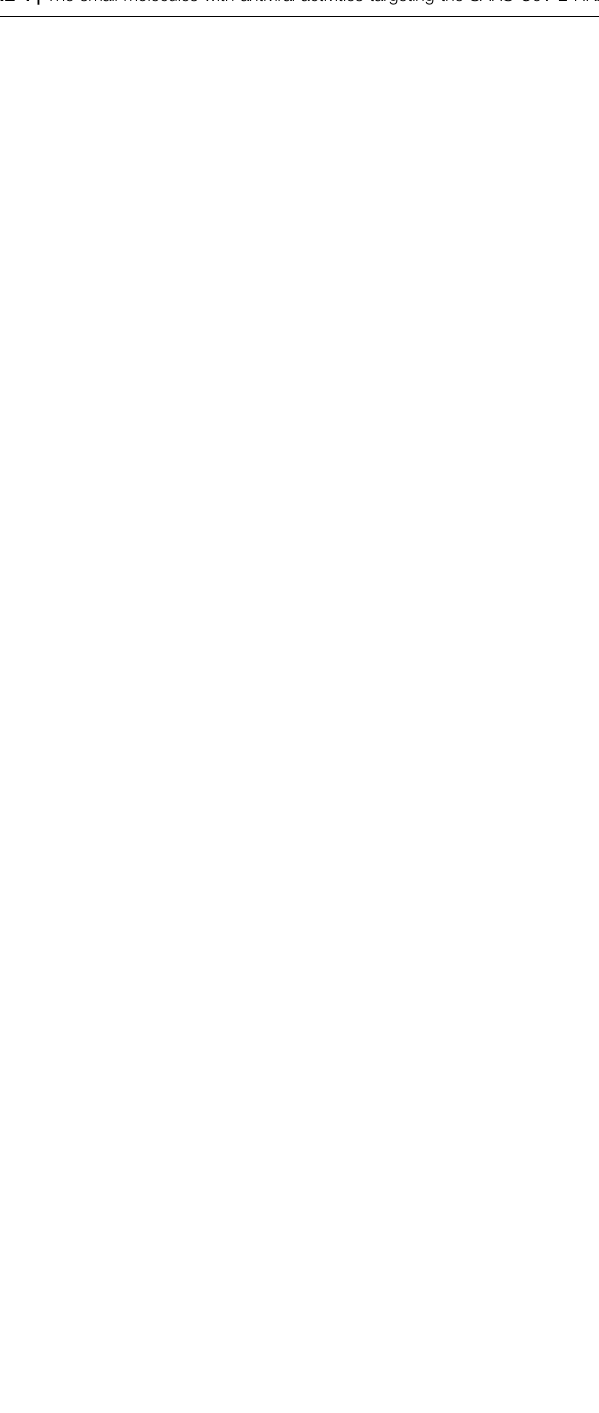
Frontiers in Chemistry |